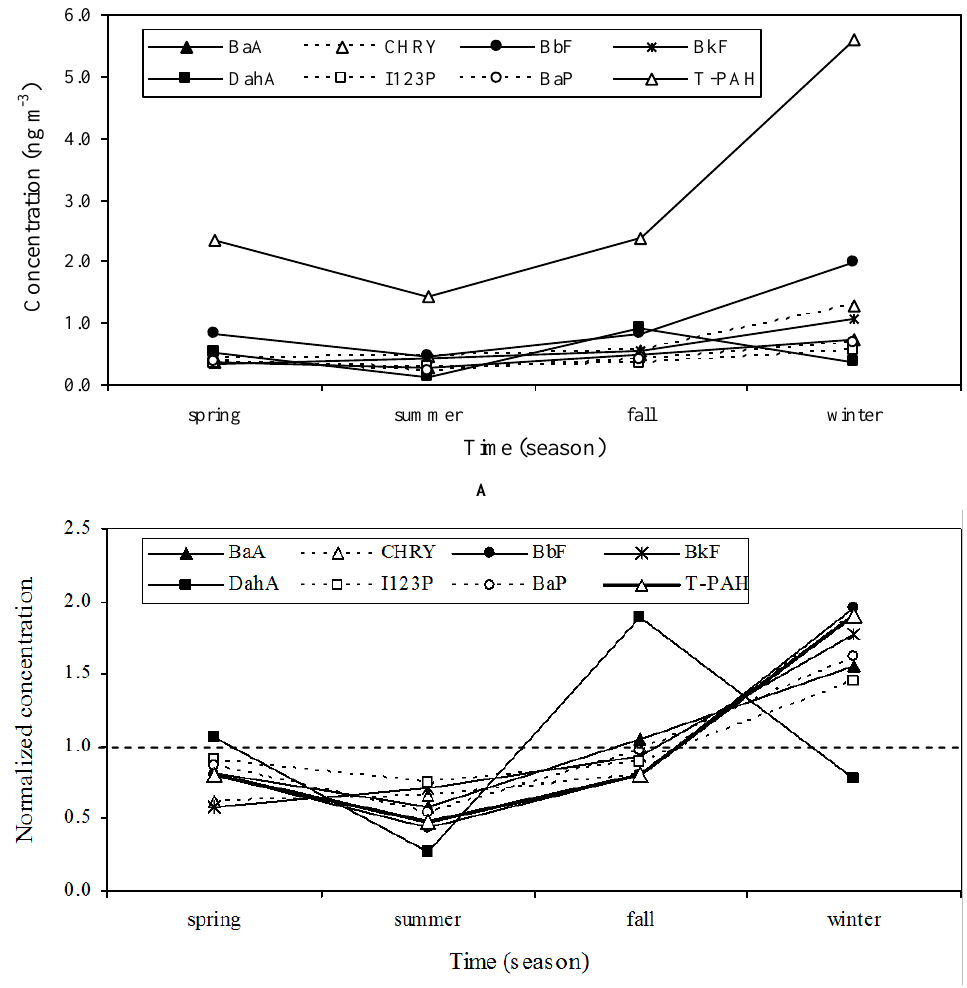
FIGURE 5. Seasonal patterns of the PAH concentration during study period. (A) Seasonal mean values; (B) normalization of seasonal mean